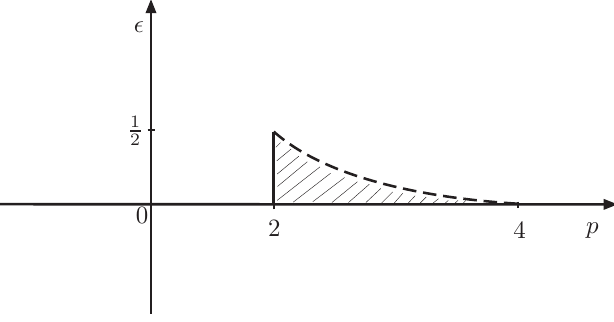
Figure 2. The regularity and integrability index